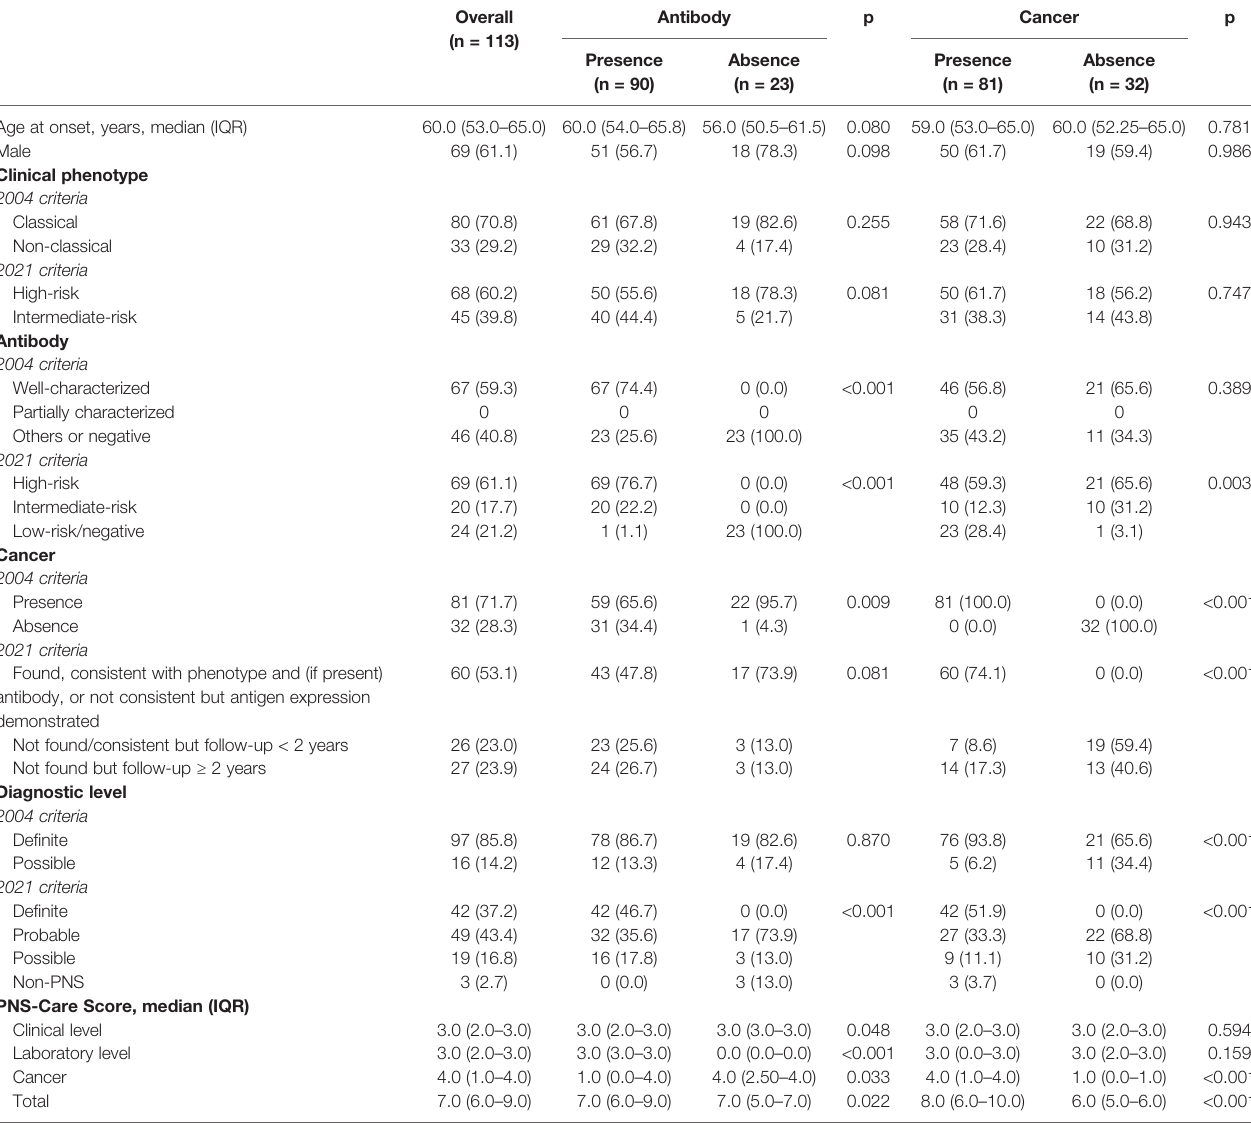
TABLE 3 | Comparison of the diagnostic criteria under speci fi c conditions.